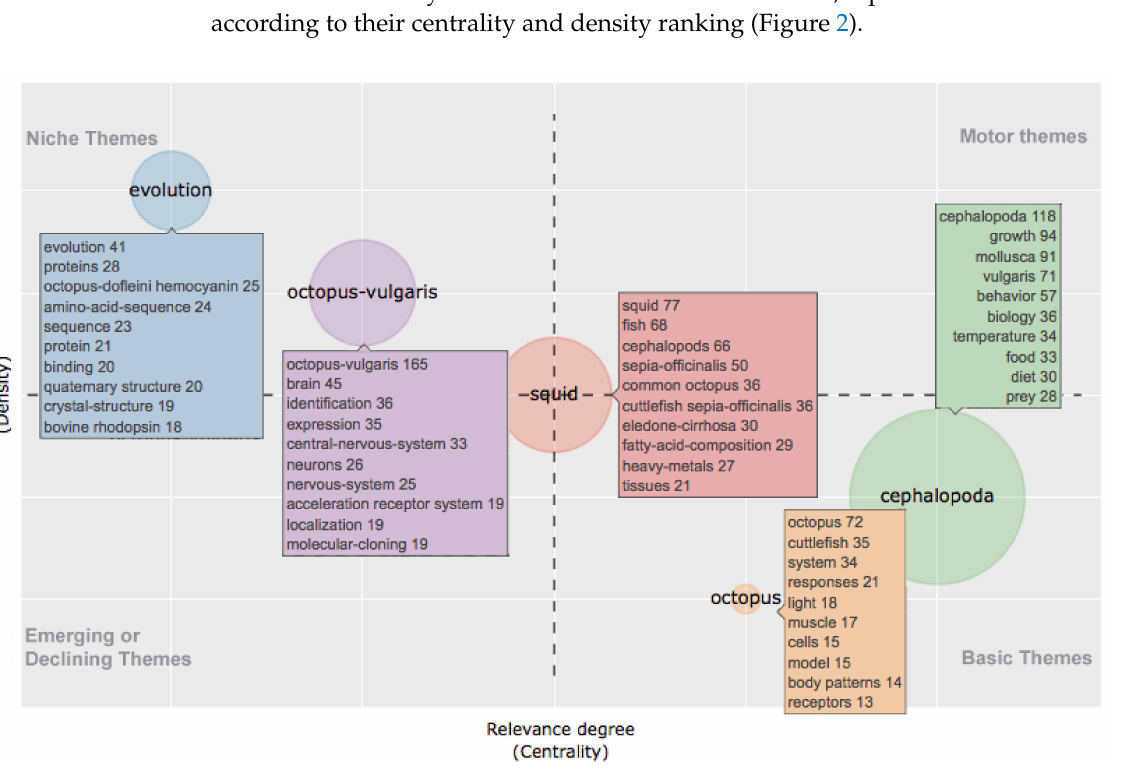
Figure 2. Thematic map showing clusters and the KeyWords Plus from 1985 to 2010 (“earlier period”) identified by the co-occurrence network. The X -axis represents the centrality (i.e., the degree of interaction of a network cluster in comparison with other clusters) and gives information about the importance of a theme. The Y -axis symbolizes the density (i.e., measures the internal strength of a cluster network, and it can be assumed as a measure of the theme’s development). Accordingly, the first quadrant identifies motor themes (i.e., well developed and important themes for the structuring of a research field); in the second quadrant are plotted highly developed and isolated themes (i.e., themes of limited importance for the field); the third quadrant contains emerging or declining themes (i.e., themes weakly developed and marginal); in the fourth quadrant fall basic and transversal themes (i.e., they concerns general topics that are transversal to different research areas of the